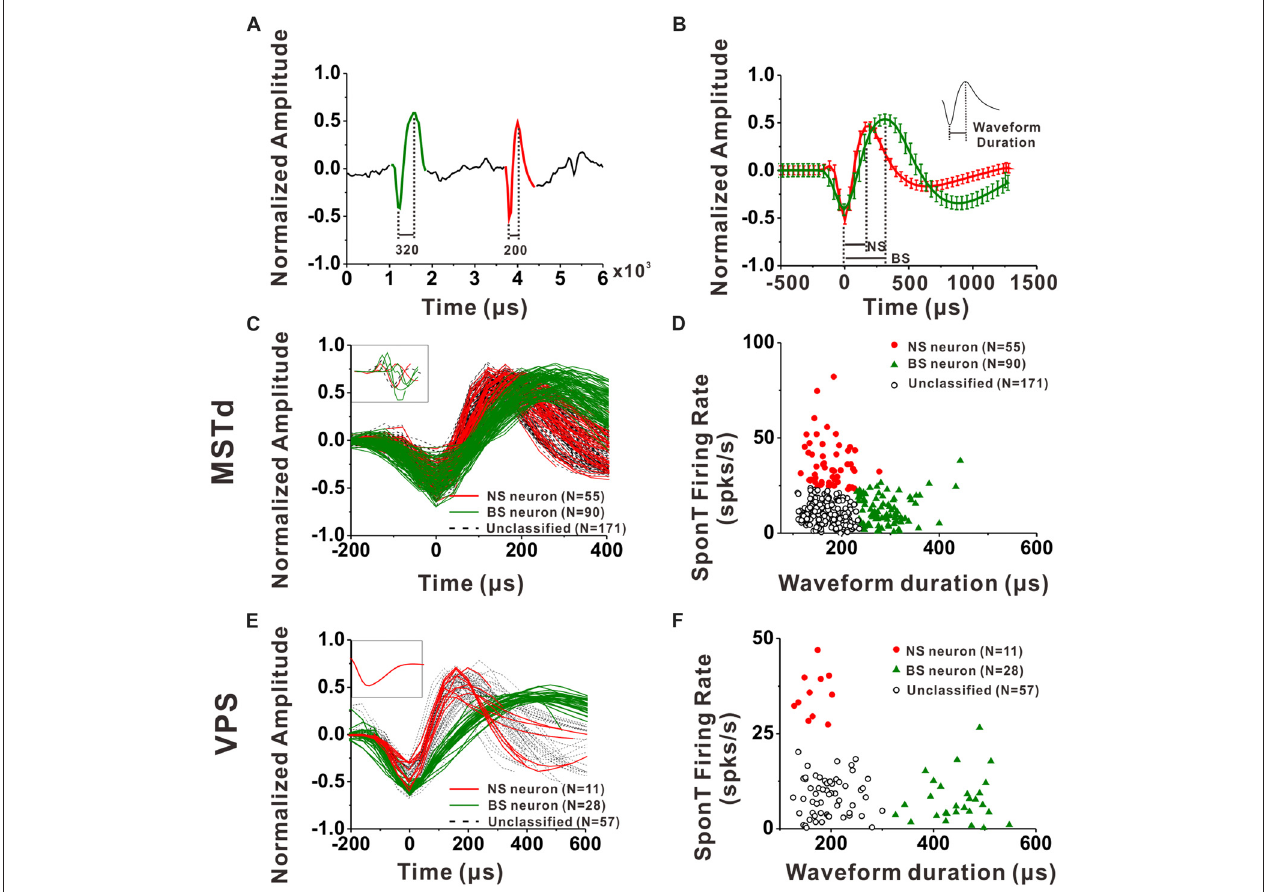
FIGURE 2 | Classification of narrow-spiking (NS) and broad-spiking (BS) neurons. (A) Original spike waveforms of two distinct neurons isolated from simultaneous recordings of one electrode. The trough to peak durations of these two neurons are 200 µ s (red, NS) and 320 µ s (green, BS), respectively. (B) Average spike waveforms (mean ± SD, normalized by dividing the difference between the peak value and the trough value) of two distinct neurons isolated from simultaneous recordings of one electrode. The two waveforms were aligned by their troughs. The trough to peak durations of these two neurons are 188 µ s (red, NS) and 313 µ s (green, BS) respectively. Inserted is the illustration of trough to peak duration of a standard waveform. (C) The average waveforms of every neuron in the group of dorsal subdivision of the medial superior temporal (MSTd) neurons. The waveforms of eight neurons without general biphasic shape are inserted in the top left corner. (D) Classification results of all the isolated MSTd neurons using K-means clustering analysis running on the distribution of spike durations and SponTs. (E) The average waveform of every neuron in the group of visual posterior sylvian fissure (VPS) neurons. The waveforms of the discarded neuron are inserted in the top left corner. (F) Classification results of all the isolated VPS neurons using K-means clustering analysis running on the distribution of spike durations and SponTs.